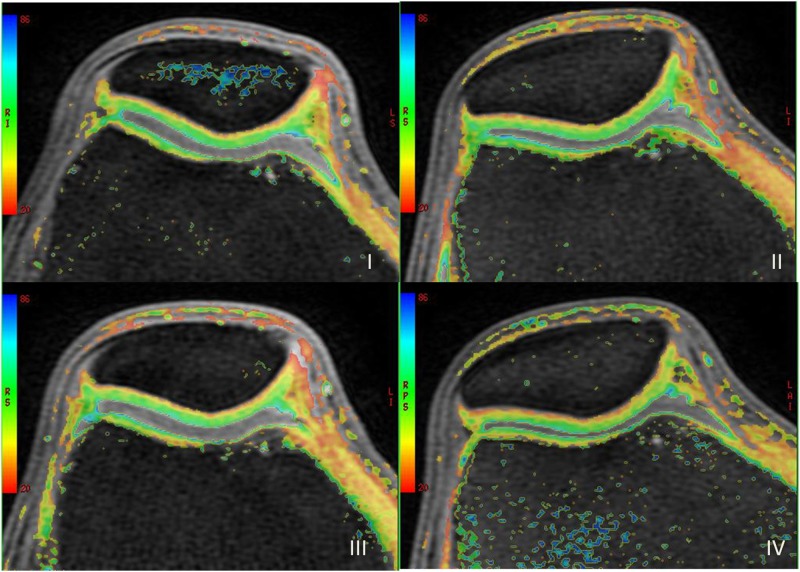
The T1 rho pseudo color maps after 30 minutes rest(I), walking(II), running(III) and stair activity(IV) presented the color of cartilage in a range from green to yellow for the superficial layer and from yellow to red in the deep layer.